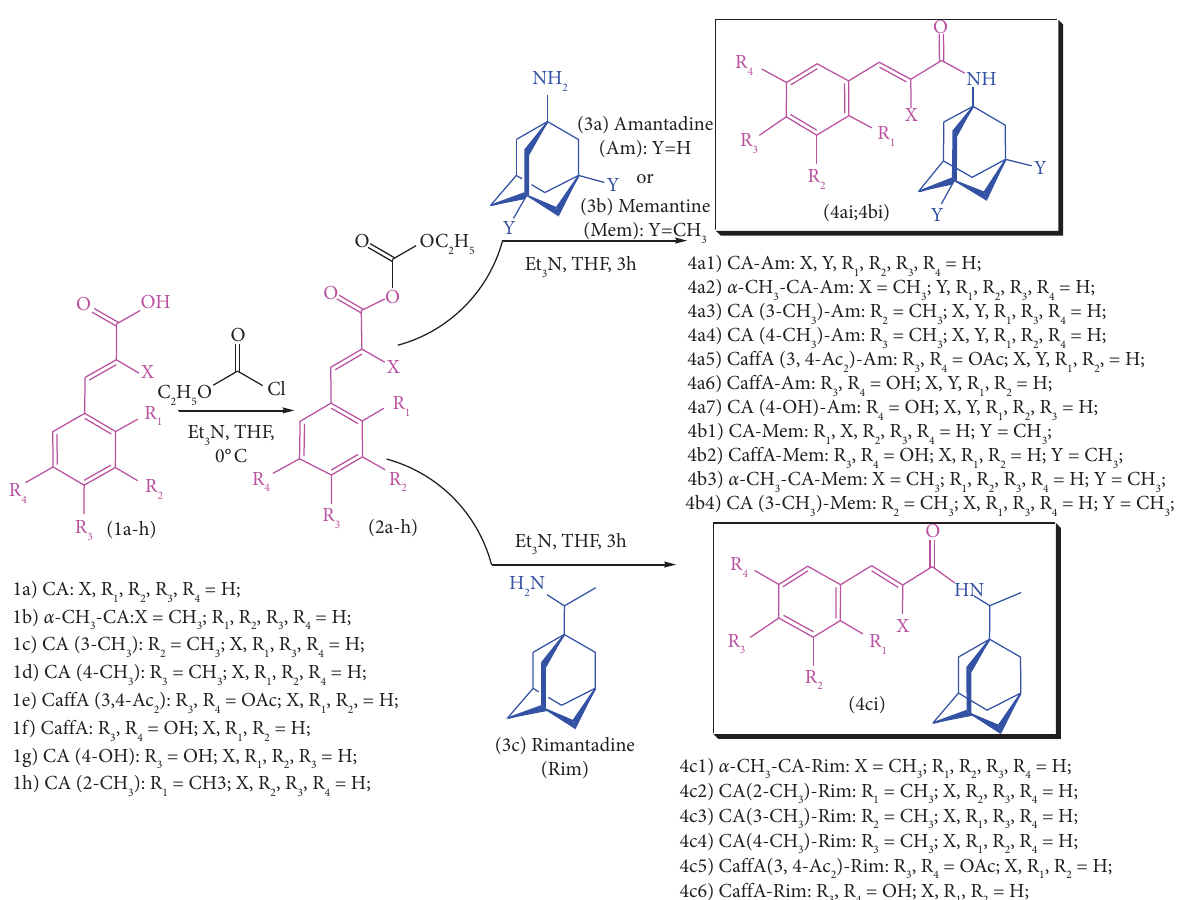
Scheme 1: Synthesis of cinnamoylamides of aminoadamantanes (Am, Mem, and